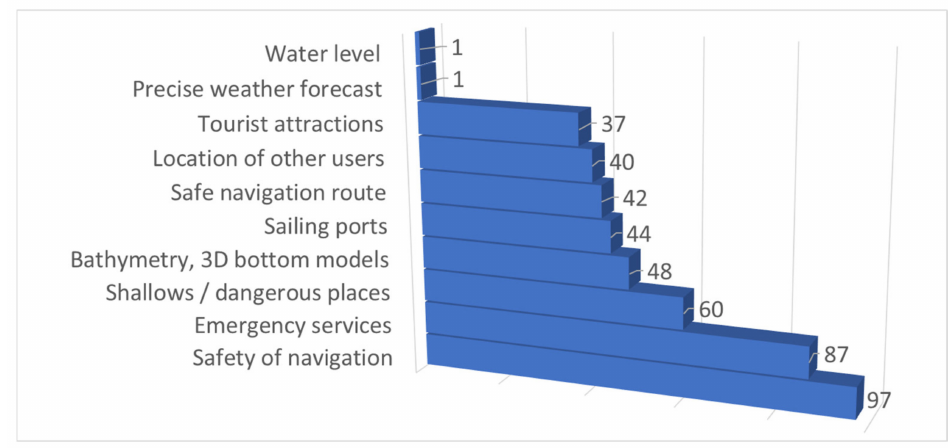
Figure 2. Identification of prioritised functionalities from the perspective of the mobile applica- tion